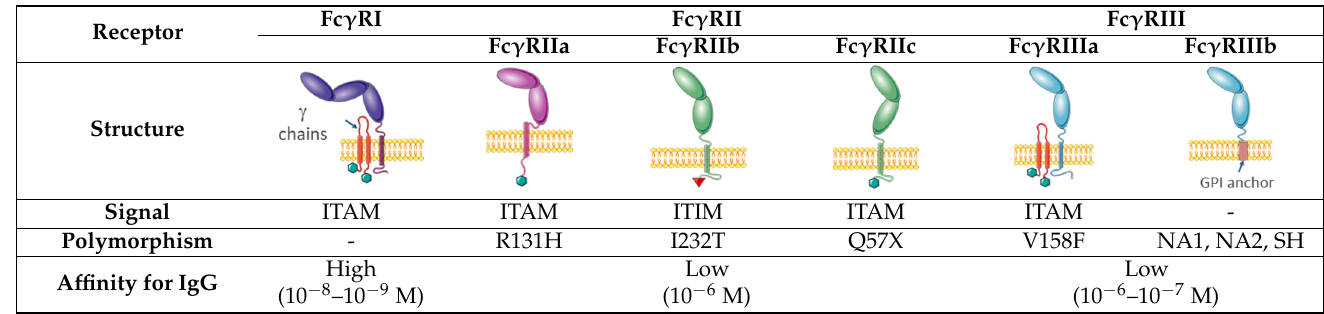
Table 2. Characteristics of Fc γ receptors.